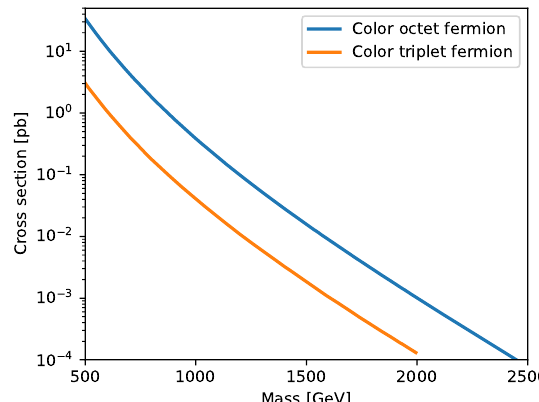
Figure 2. Comparison of the production cross sections of a color triplet top partner (at QCD NLO, from [55]) and a color octet Majorana top partner (at NNLO